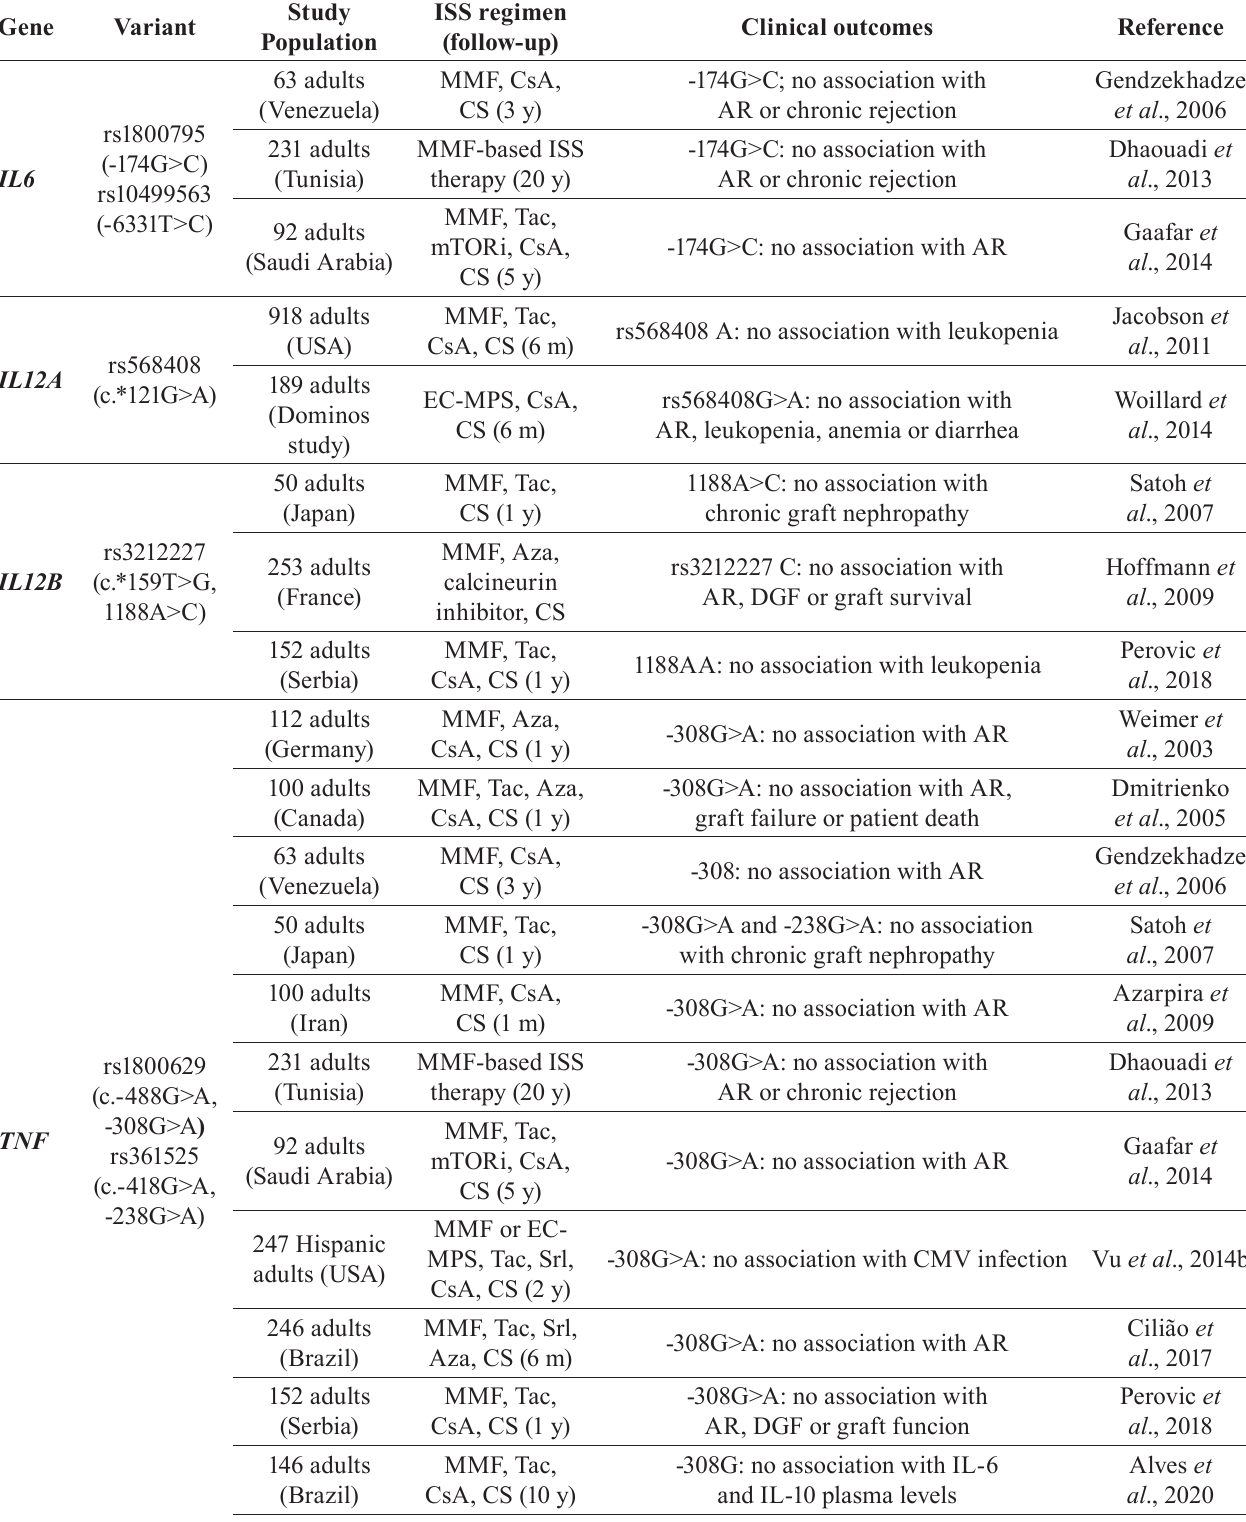
TABLE IV - Genes related to pro-inflammatory cytokines in kidney recipients on MPA therapy without significant associations